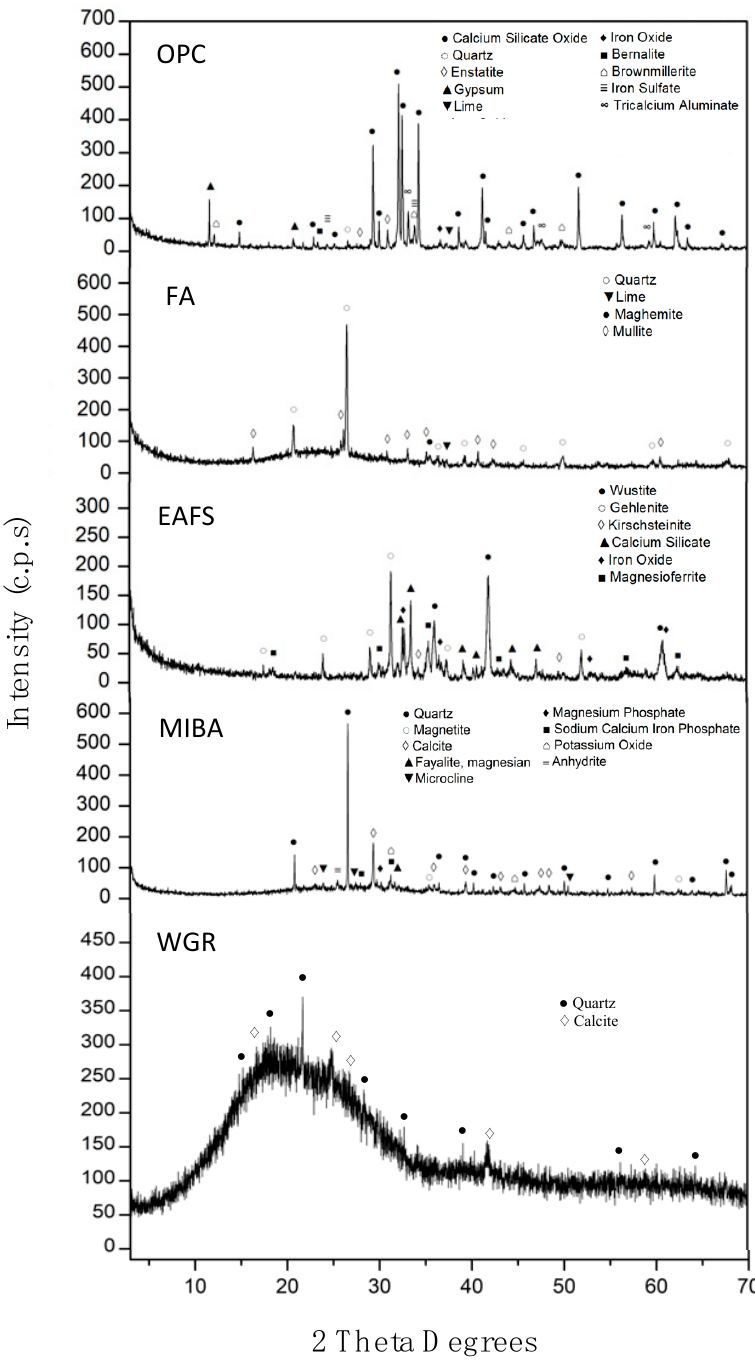
Figure 2. XRD analysis of OPC, FA, EAFS, MIBA, and WGR.